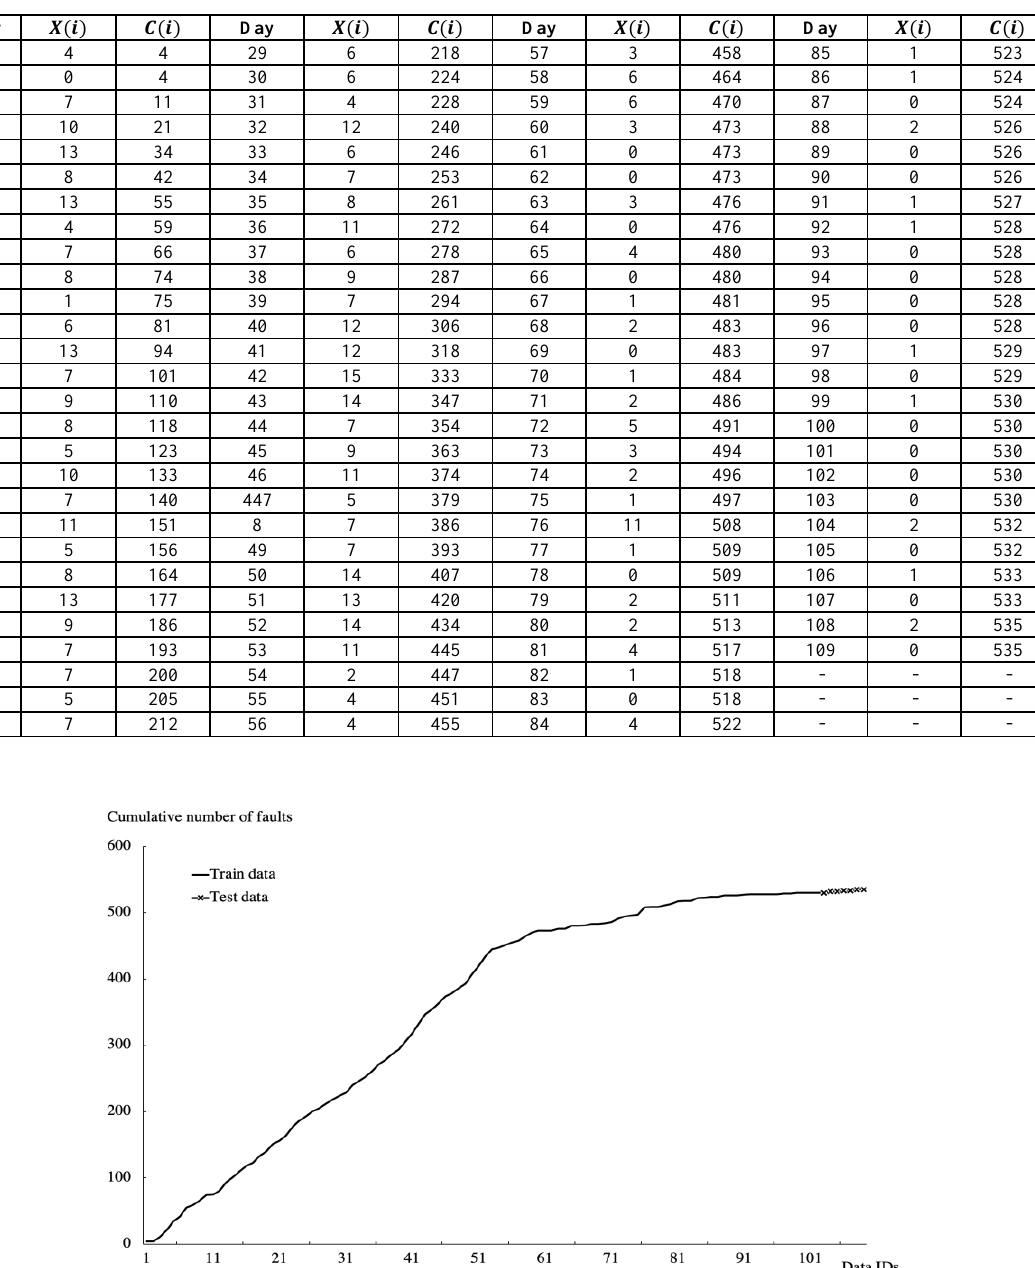
Figure 5. Training data and test data of the fault